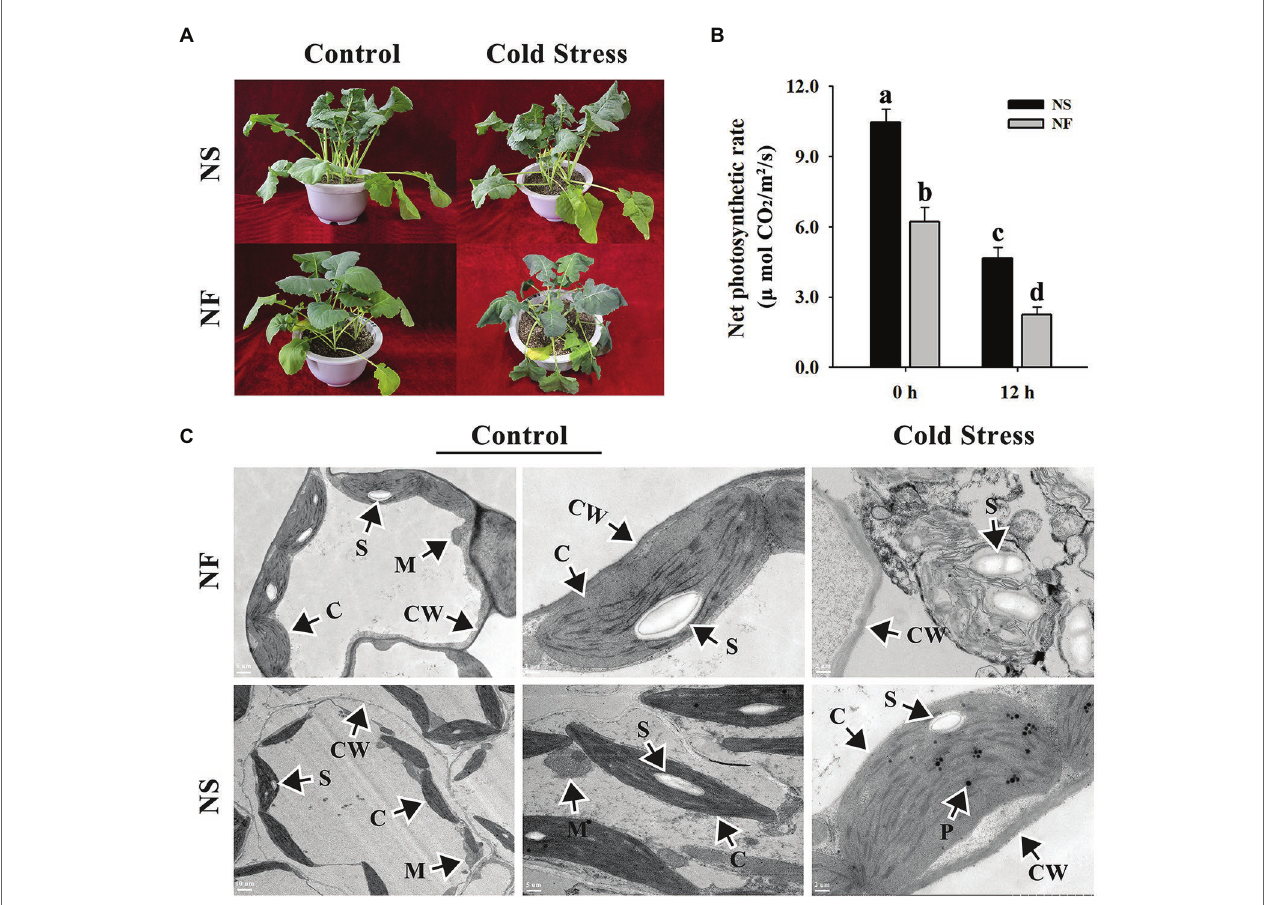
FIGURE 1 | Morphological and photosynthetic changes in the leaves of winter rapeseed under freezing stress. (A) Illustration of 5-week-old winter rapeseed plants under freezing treatment. (B) The net photosynthetic rates of rapeseed cultivars NF and NS under freezing treatment. Values of p are means ± SD from three biological replicates ( p < 0.05). (C) Microstructure changes in the leaves of both cultivars under freezing treatment for 12 h and control, respectively. C, chloroplast; CW, cell wall; M, mitochondrion; P, plastoglobulus; S, starch